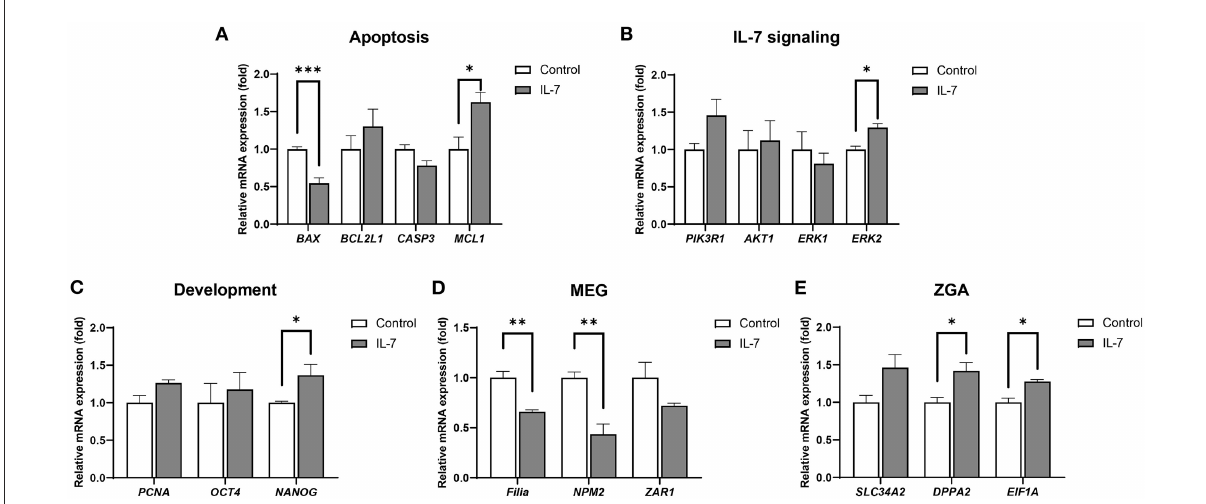
FIGURE5 Relative mRNA expression levels of genes associated with apoptosis, IL-7 signaling, development, maternal effect genes (MEGs), and zygotic genome activation (ZGA) in IL-7-treated day 2 embryos. The mRNA expression levels of (A) apoptosis-related genes ( BAX , BCL2L1 , CASP3, and MCL1 ), (B) IL-7 signaling-related genes ( PIK3R1 , AKT1 , ERK1 , and ERK2), (C) Development-related genes ( PCNA , OCT4 , and NANOG ), (D) MEGs ( Filia , NPM2 , and ZAR1 ), and (E) ZGA-related genes ( SLC34A2 , DPPA2 , and EIF1A ) in day 2 embryos from control and 10ng/mL IL-7 treatment group. Data were normalized to the RN18S gene. Asterisks indicate statistical significance (* p < 0.05, ** p < 0.01, and *** p < 0.001). For all graphs, the value represents mean ± SEM. The experiments were replicated three or four